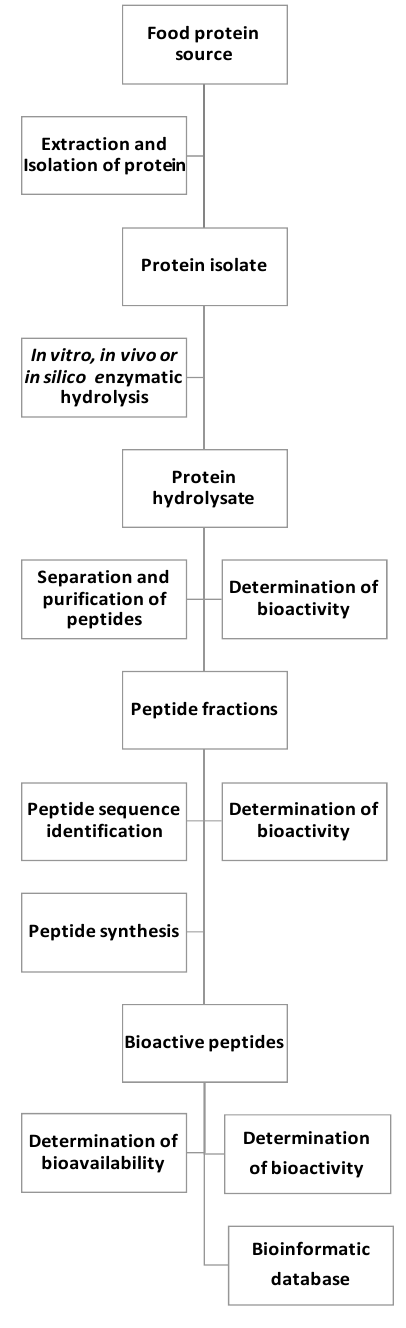
Figure 1. Scheme of bioactive peptide preparation.